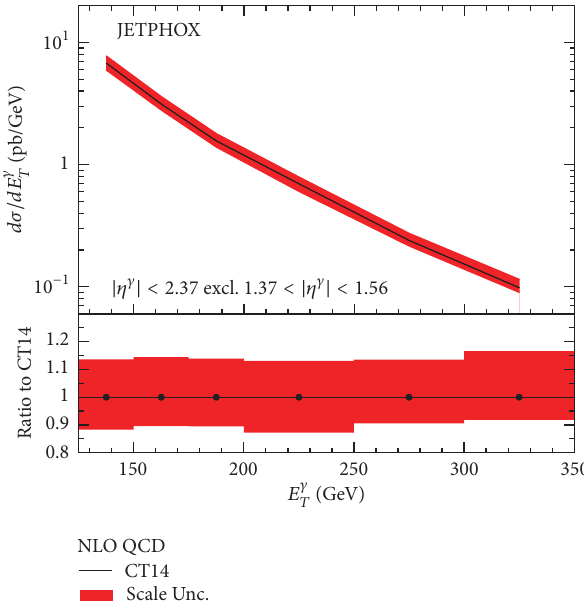
Figure 5: The NLO theoretical predictions for the total differential cross section of the isolated prompt photon as a function of 𝐸 using NLO CT14 [92] PDFs with scale uncertainty (red band) at √𝑠 = 13 TeV in the kinematic range 125 < 𝐸 𝛾 |𝜂 𝛾 | < 2.37 excluding the region 1.37 < |𝜂 𝛾 | < 1.56 . Ratio to the central value of CT14 has been shown in the bottom